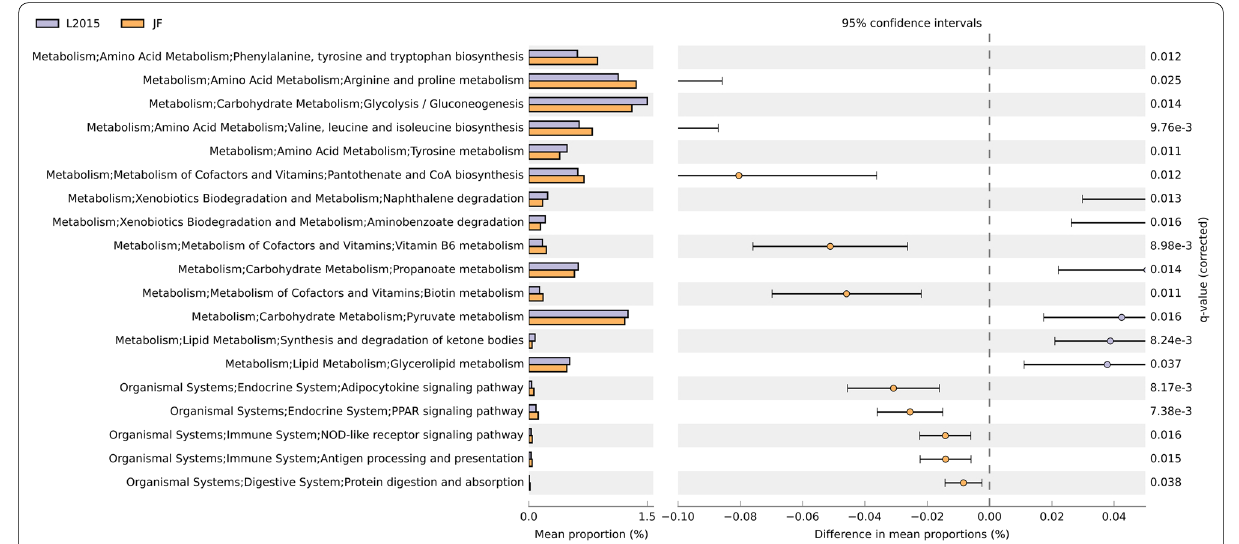
Fig. 11 Predicted functions of ileal mucosa microbiota in modern random bred chickens (L2015) compared to their ancestor jungle fowl (JF) on d 56. Differentially regulated (top 20) metabolic pathways are shown. (n